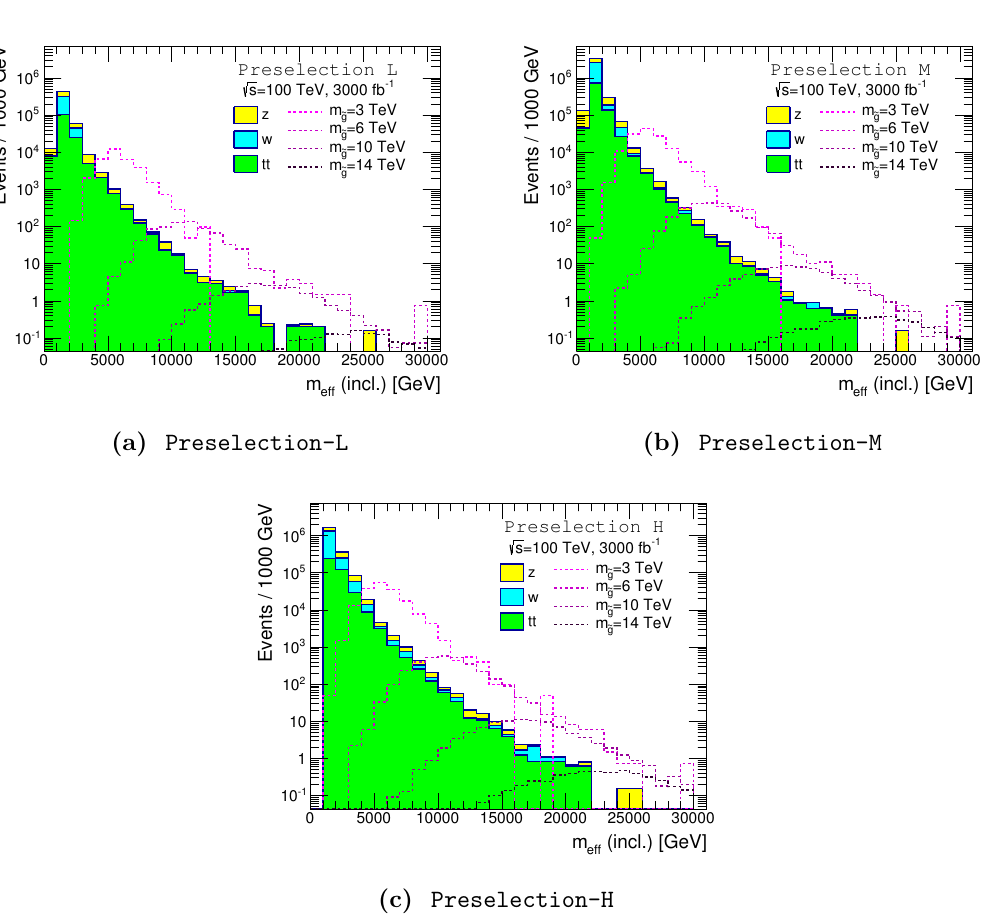
Figure 17. Distributions of m e(cid:11) (incl.) for the SM background and gluino signal events. We set the LSP mass to be 100